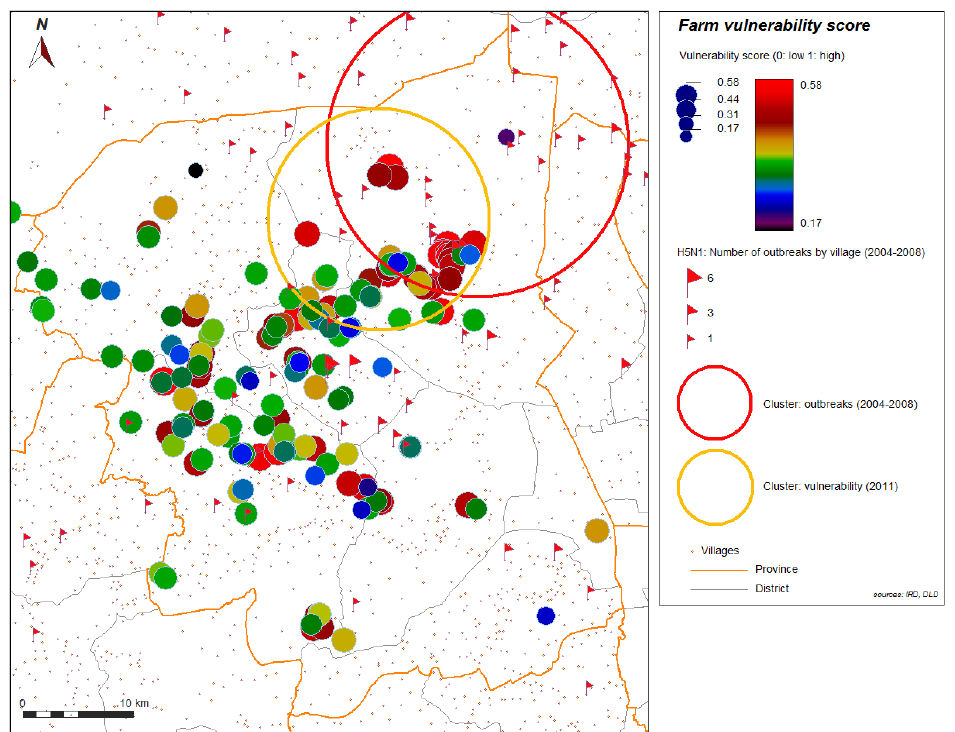
Figure 6. Most significant cluster of vulnerability (yellow), farms sector 2 and 3, and most significant cluster (red) of 2004–2008 H5N1 HPAI outbreaks, Nakhon Pathom province,